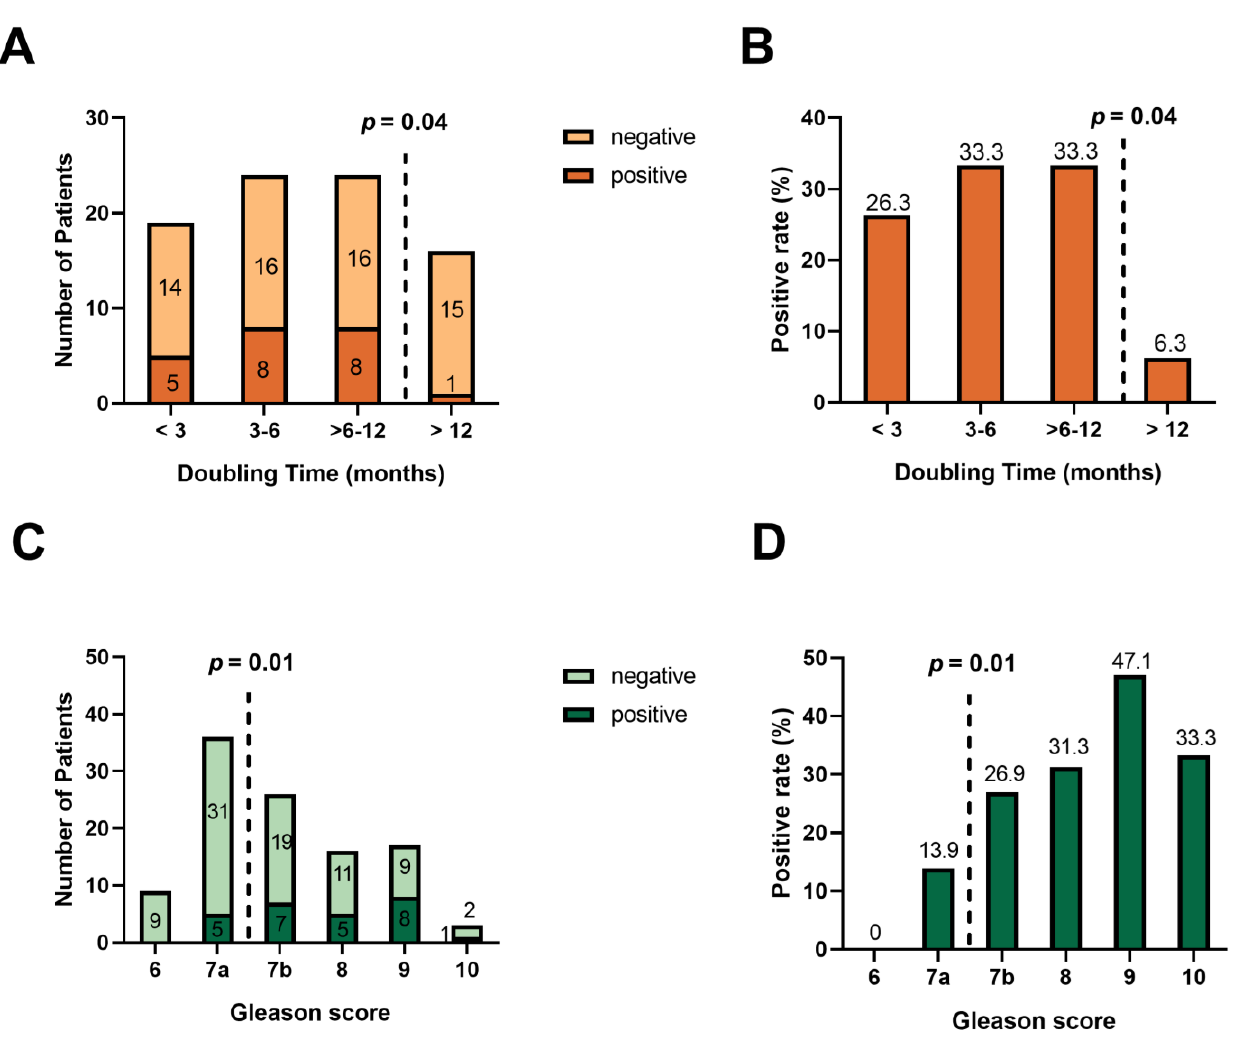
Figure 4. Rate of detection on 68 Ga-PSMA-11 PET/CT of lesions suspicious for prostate cancer in 115 men with BCR and very low PSA concentration ( A , B ) by PSA doubling time category (in months) ( n = 83) and ( C , D ) by Gleason score of surgical specimen ( n = 107). Panels ( A , C ) show numbers of patients with positive or negative scans, while panels ( B , D ) depict the overall suspicious lesion detection rate in percent (numbers atop the bars). Detection rates are significantly higher ( p = 0.04) in patients with doubling time < 12 months ( n = 67) than in their counterparts with doubling time > 12 months ( n = 16). Additionally, detection rates are significantly higher ( p = 0.01) in men with a